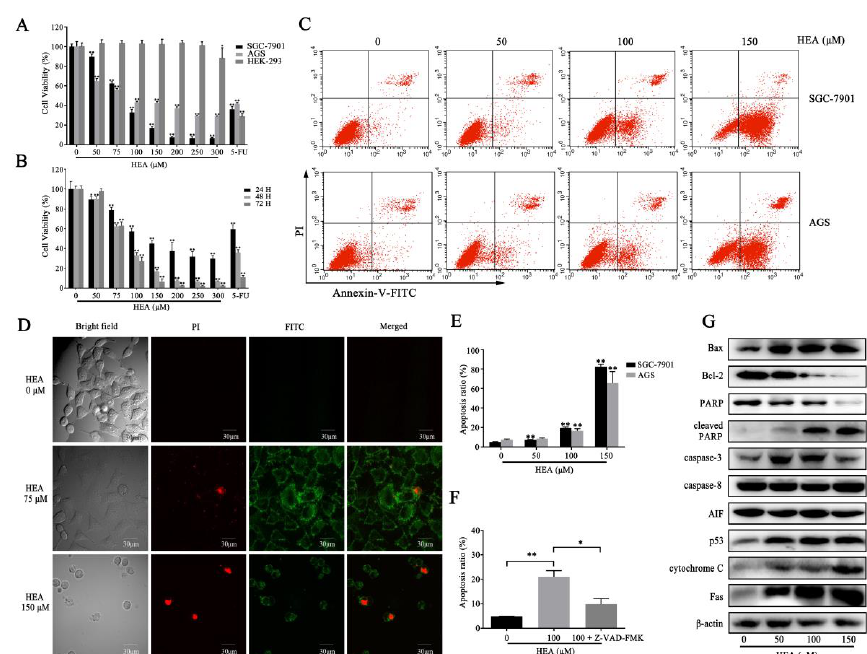
Figure 2. HEA induced inhibitory e ff ects in gastric carcinoma cells. ( A ) Estimation of cytotoxicity using CCK-8 assay with various doses of HEA in SGC-7901, AGS, and HEK293 cells. The cells (SGC-7901, AGS, and HEK293) were treated with 0, 50, 75, 100, 150, 200, 250, and 300 µ M HEA and 20 µ g · mL − 1 5-FU for 48 h and were then detected using CCK-8 assay, with five repeats per group. ( B ) Evaluation of cytotoxicity using CCK-8 assay with various doses of HEA at di ff erent treatment times in SGC-7901 cells. SGC-7901 cells were treated with HEA and 5-FU for 24, 48, and 72 h and were then evaluated for cell viability, with five repeats per group. ( C ) HEA promoted apoptosis of gastric carcinoma SGC-7901 and AGS cells. SGC-7901 and AGS cells were incubated with HEA (0, 50, 100, and 150 µ M) for 48 h, and apoptosis level was detected via Annexin V-FITC / PI assay. ( D ) Apoptosis level changes in SGC-7901 cells detected by a laser confocal microscope after Annexin V-FITC / PI staining. ( E ) Columns for SGC-7901 and AGS apoptosis levels when incubated with HEA (0, 50, 100, and 150 µ M). ( F ) Columns for apoptotic SGC-7901 cells incubated with vehicle, HEA (100 µ M), and HEA (100 µ M) + Z-VAD-FMK (20 µ M). ( G ) E ff ect of HEA on protein apoptosis in relation to SGC-7901 cells. Cells were treated with HEA (0, 50, 100, and 150 µ M), and proteins were extracted for Western blot analysis. ** p < 0.01, * p < 0.05 compared with 0 µ M HEA group, three repeats per